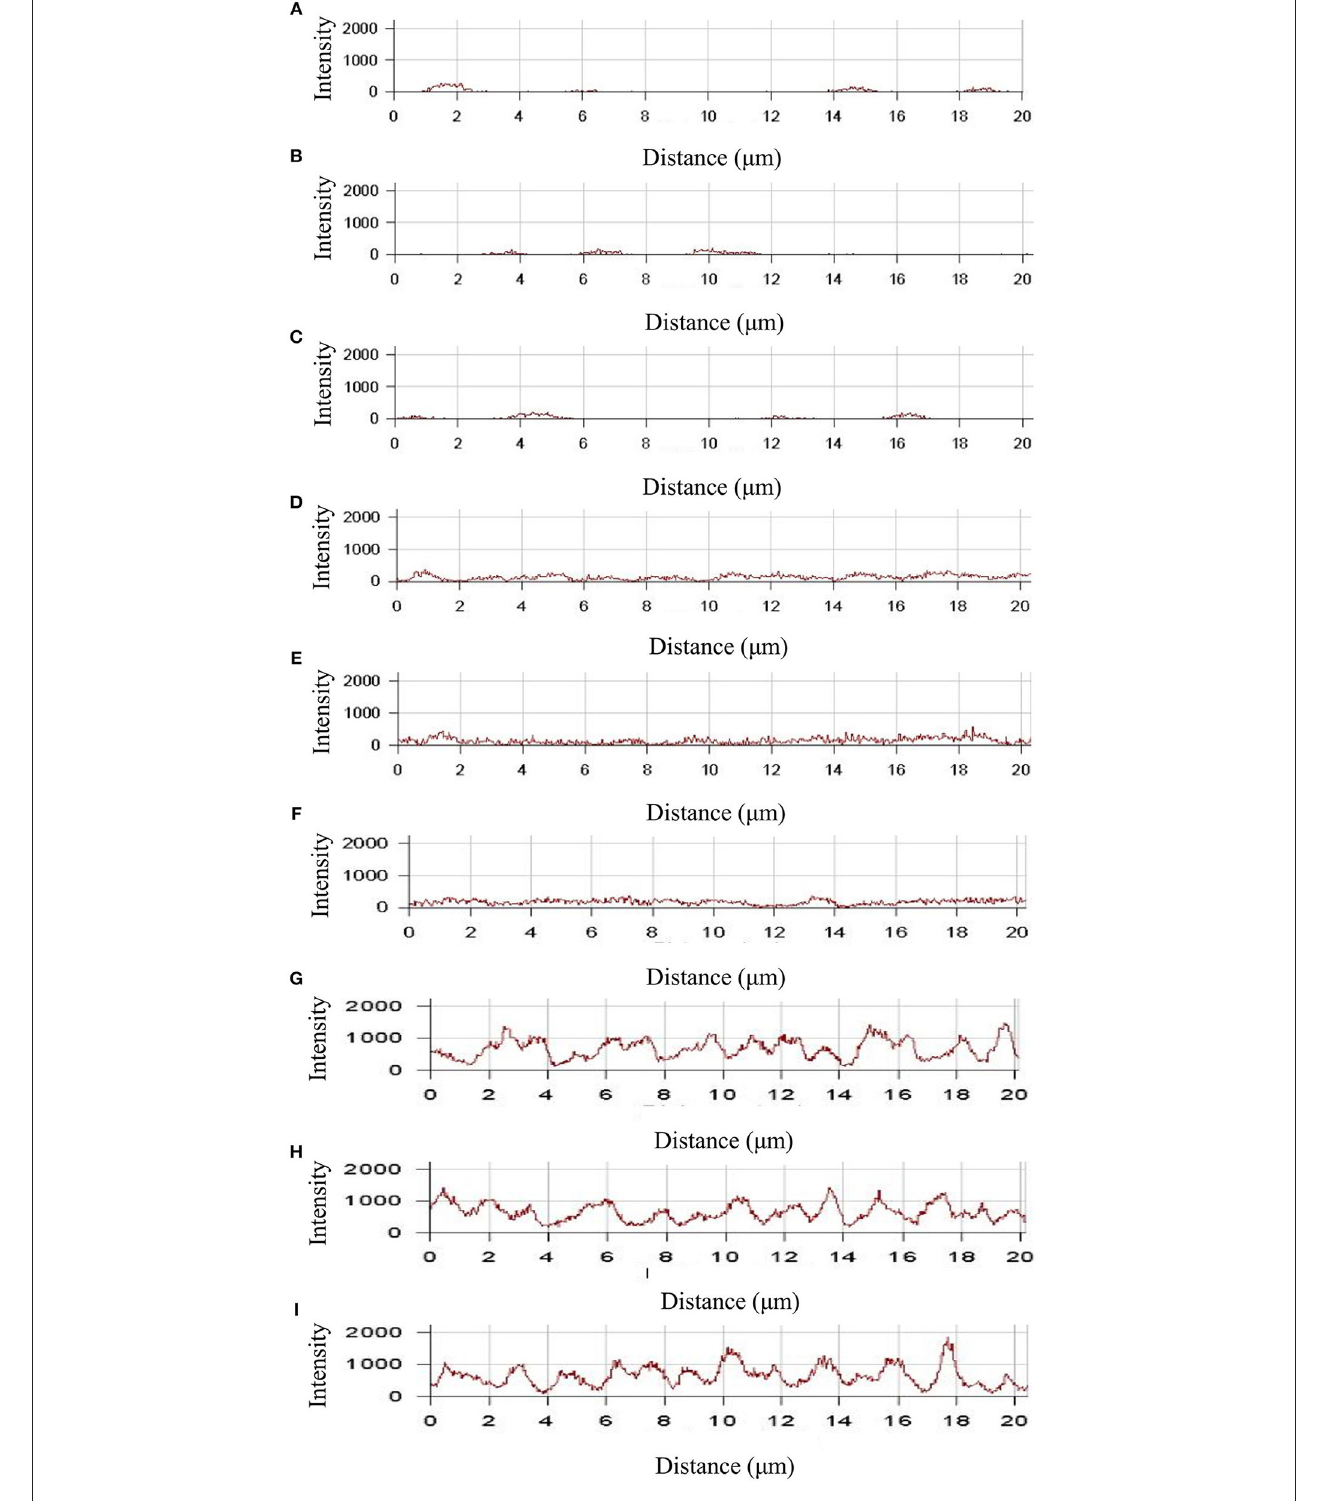
FIGURE 8 | The fluorescence intensity was obtained by CLSM in S. xylosus uptake doxorubicin hydrochloride. (A–C) The fluorescence intensity of S. xylosus was treated with only doxorubicin hydrochloride for 30min, 1 and 3h, respectively. (D–I) S. xylosus was treated with CD-g-CS (Q CD = 0.643 × 10 3 µ mol/g) and CD-g-CS (Q CD = 0.6 × 10 2 µ mol/g) that contained doxorubicin hydrochloride for 30min, 1 and 3h, respectively.